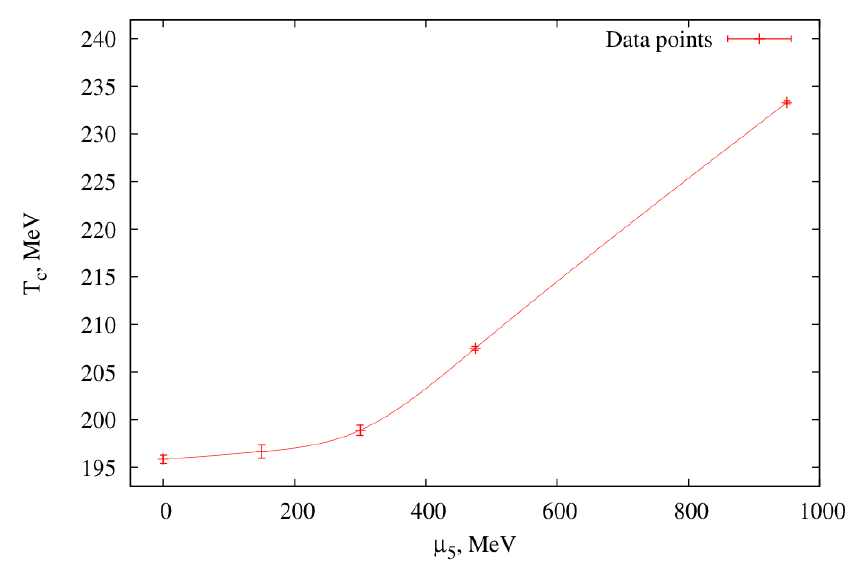
Figure 10. The phase diagram of QCD (two-color) in the temperature-chiral chemical potential plane; note the enlargement of the hadronic phase due to the enhancement of chiral breaking. From Ref. [73].